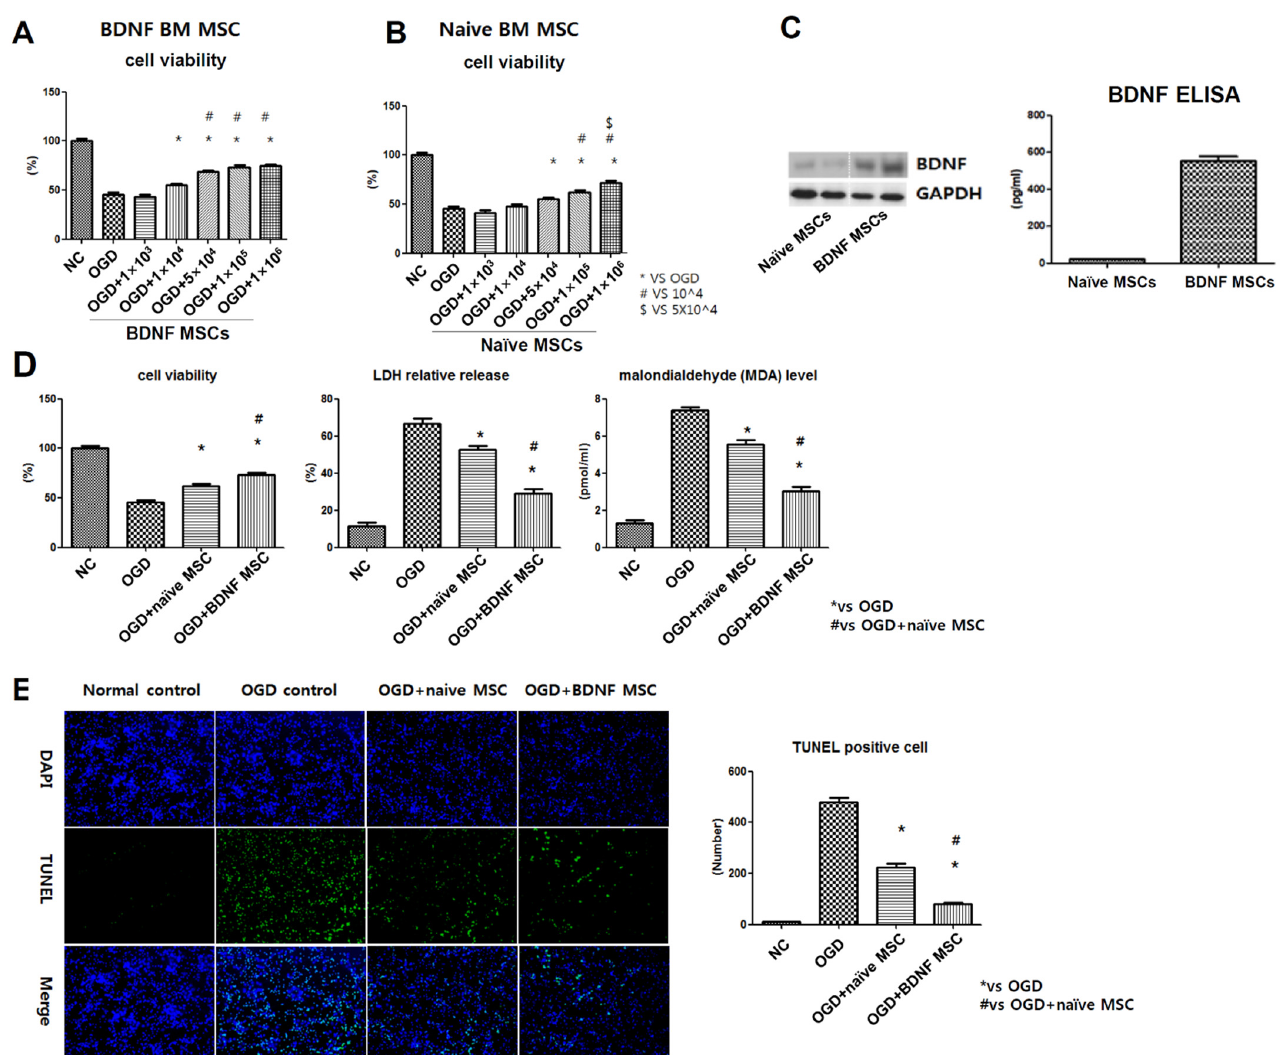
Figure 2. Neuroprotective efficacy of BDNF-eMSCs in vitro oxygen–glucose deprivation (OGD)-induced primary cultured rat cortical neurons. Cell viability, which is expressed as relative proliferation rate (%) to normal control group, was assessed with the CCK-8 assay in OGD-induced cultured neurons after co-treatment with BDNF-eMSCs, at doses of approximately 1 × 10 3 , 1 × 10 4 , 5 × 10 4 , 1 × 10 5 , 1 × 10 6 cells per 1 mL, ( A ) and with naïve MSCs at doses of approximately 1 × 10 3 , 1 × 10 4 , 5 × 10 4 , 1 × 10 5 , 1 × 10 6 cells per 1 mL ( B ). ( C ) Western blotting and ELISA assay for BDNF expression from the culture media of naïve MSCs and BDNF-eMSCs. ( D ) Cytotoxicity was evaluated with cell viability, expressed as a relative proliferation rate (%) to the normal control group, relative lactate dehydrogenase (LDH) release (%) to the positive control (100% fully killed cells), malondialdehyde (MDA) level in neuronal cells after OGD induction with/without co-treatment of naïve MSCs or BDNF-eMSCs at a dose of 1 × 10 5 cells per 1 mL. ( E ) The number of terminal deoxynucleotidyl transferase UTP nick end labeling (TUNEL)-positive cells evaluated in OGD-induced rat cortical neurons after co-culture with naïve MSCs or BDNF-eMSCs at dose of 1 × 10 5 cells per 1 mL. Data are expressed as the mean ±